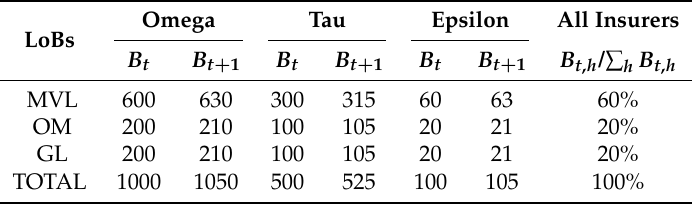
Table 2. Baseline Portfolio Mix in terms of Gross premium volumes (amounts in million of Euro). LoBs